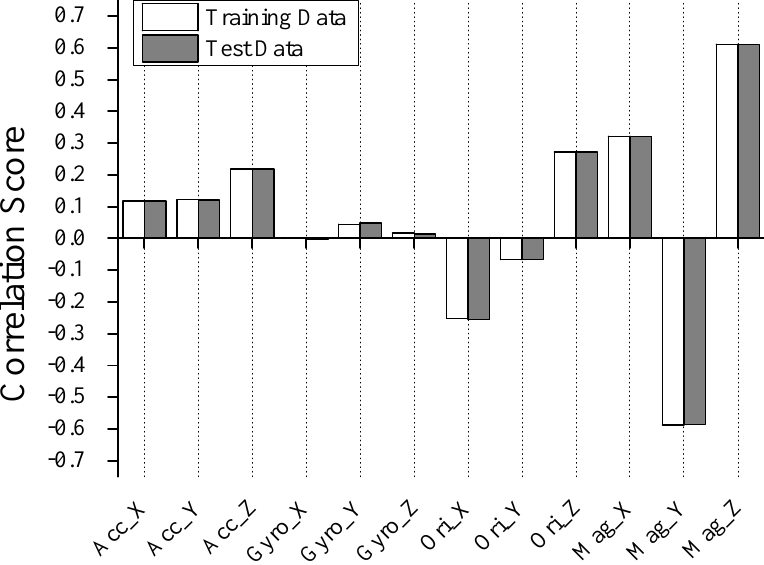
Figure 6. Correlation graph of sensor